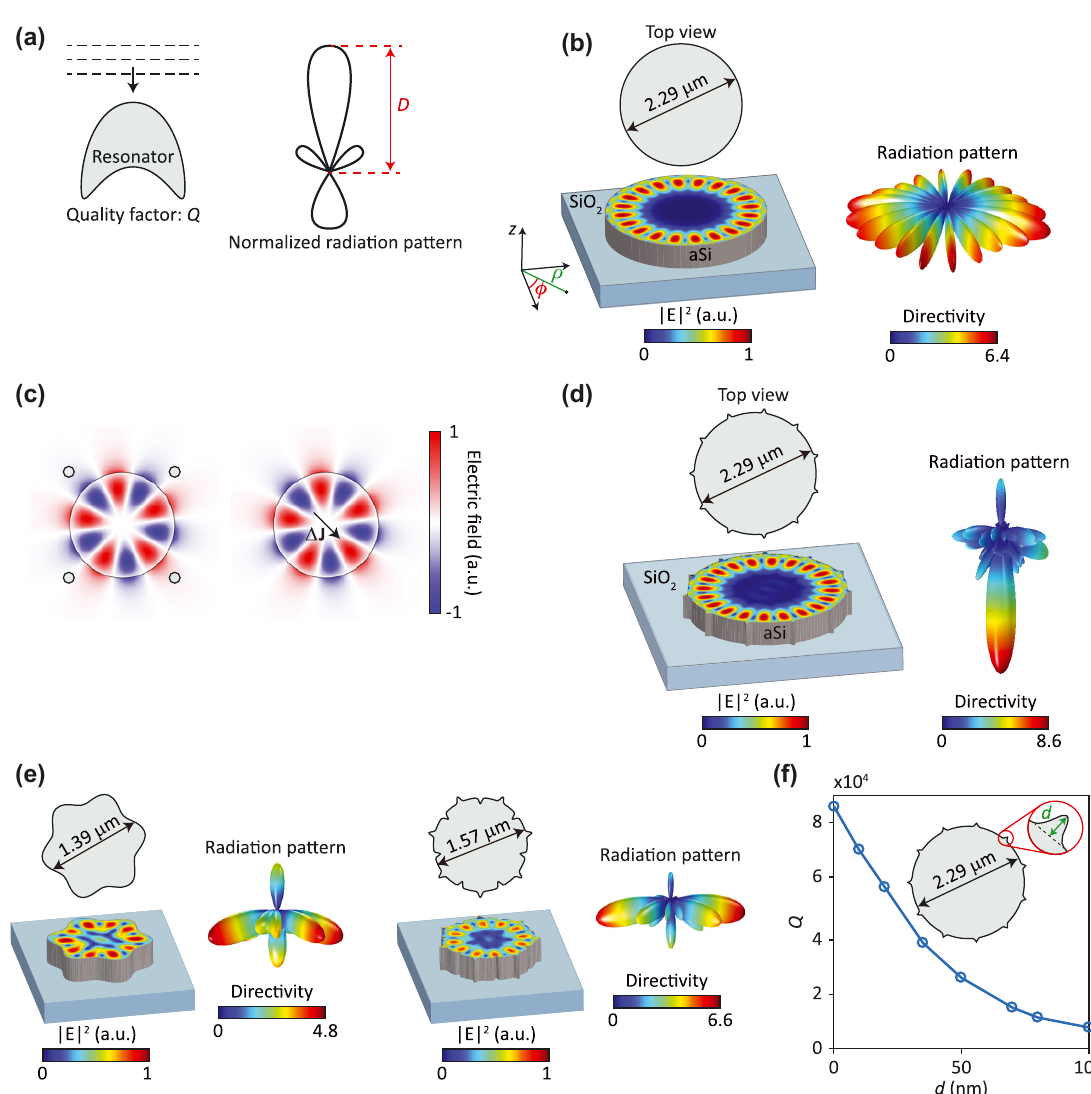
Figure 1: Excitation of free-space-coupled resonators. (a) Schematicillustration of a resonatorwith a quality factor Q illuminated and excited with a plane wave. The directivity pattern D ( θ , ϕ ) of the resonator, which is its normalized radiation pattern, is also shown. (b) Schematic of a microdisk resonator, a snapshot of the electric fi eld squared of one of its resonant modes with azimuthal order N =10, and its radiation pattern. (c) The electric fi eld of the resonant mode of a microdisk resonator. Small perturbations to the resonator are shown as small circles around the microdisk in the drawing on the left and can be represented by a polarization current density Δ J as shown in the drawing on the right. (d) Resonant mode and radiation pattern of an FSC microdisk resonator for a mode with azimuthal order N = 10. There are N + 1= 11 protrusions on the microdisk circumference. (e) Resonant modes and radiation patterns of two different FSC microdisk resonators for mode with azimuthal orders N = 5 and 6. There are N + 1 = 6 and 7 protrusions on the microdisks ’ circumferences. (f) The quality factor of the resonator shown in (d) as a function of the protrusion depth d N + 1 = 11 protrusions. The radiation pattern has large simulations con fi rm that weak azimuthal gratings with N ± 1 periods around the microdisk circumference lead to lobes normal to the plane of the microdisk. Figure 1e shows emission of the resonant mode in the direction normal to smaller microdisks supporting modes with N = 5 and 6 at λ = 1 . 53 μ m and refractive index modi fi cations with N + 1 the microdisk. The azimuthal grating serves a similar 0 purpose as an evanescently coupled waveguide, but periods around the microdisk circumference. These reso- instead of coupling the resonant mode to a guided mode, it nators also emit signi fi cantly normal to their planes and couples it to freely propagating waves. As the grating can be excited by normally incident plane waves. The